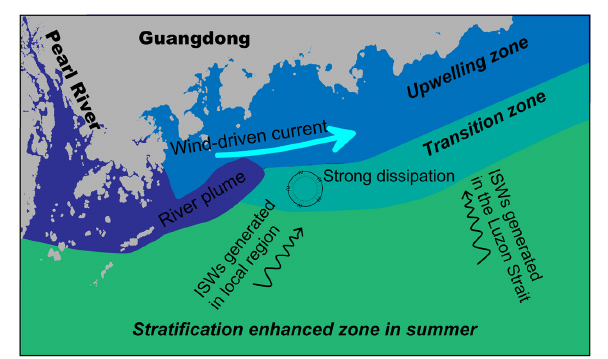
FIGURE 12 | Schematic diagram describing the propagation and dissipation processes of the ISWs. The ISWs on the continental shelf of the northern SCS are generated in the Luzon Strait and northern SCS shelf. The dissipation and evolution of ISWs couple multiple mechanisms among river plume dispersal, upwelling mixing, and wind-driven